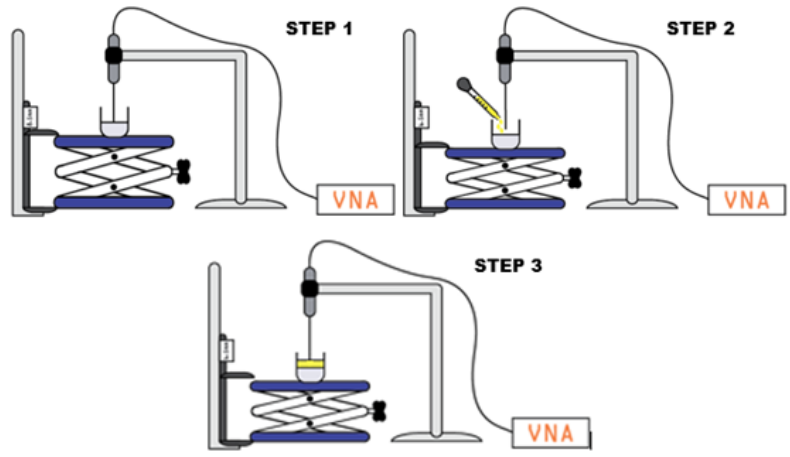
Figure 4. The process of the dielectric property measurement for sensing depth